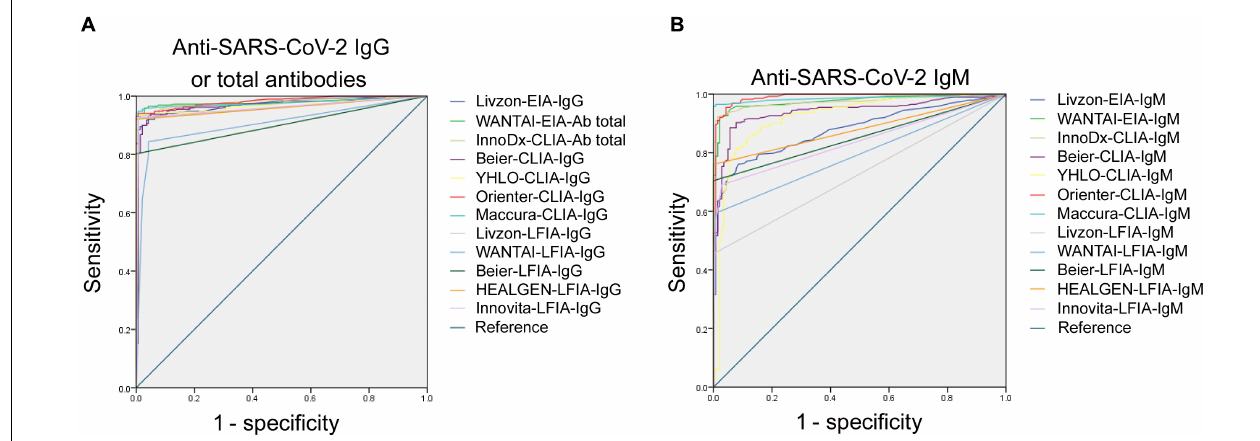
FIGURE 1 | ROC analysis of 24 SARS-CoV-2 antibody assays. (A) ROC analysis of anti-SARS-CoV-2 IgG or total antibodies with different reagents. AUCs were 0.973 (95% CI, 0.961–0.985), 0.974 (95% CI, 0.957–0.990), 0.979 (95% CI, 0.968–0.990), 0.969 (95% CI, 0.953–0.986), 0.972 (95% CI, 0.959–0.985), 0.984 (95% CI, 0.976–0.993), 0.980 (95% CI, 0.968–0.991), 0.958 (95% CI, 0.941–0.976), 0.899 (95% CI, 0.871–0.927), 0.901 (95% CI, 0.872–0.930), 0.960 (95% CI, 0.943–0.979), 0.962 (95% CI, 0.945–0.979), and 0.968 (95% CI, 0.954–0.983) for Livzon-EIA-IgG, WANTAI-EIA-Ab total, InnoDx-CLIA-Ab total, Beier-CLIA-IgG, YHLO-CLIA-IgG, Orienter-CLIA-IgG, Maccura-CLIA-IgG, Livzon-LFIA-IgG, WANTAI-LFIA-IgG, Beier-LFIA-IgG, HEALGEN-LFIA-IgG, and Innovita-LFIA-IgG, respectively. (B) ROC analysis of anti-SARS-CoV-2 IgM with different reagents. AUCs were 0.865 (95% CI, 0.835–0.896), 0.976 (95% CI, 0.964–0.988), 0.974 (95% CI, 0.962–0.987), 0.946 (95% CI, 0.926–0.966), 0.927 (95% CI, 0.900–0.955), 0.984 (95% CI, 0.973–0.995), 0.979 (95% CI, 0.966–0.991), 0.733 (95% CI, 0.692–0.774), 0.787 (95% CI, 0.750–0.824), 0.852 (95% CI, 0.817–0.887), 0.849 (95% CI, 0.818–0.880), and 0.831 (95% CI, 0.797–0.864) for Livzon-EIA-IgM,